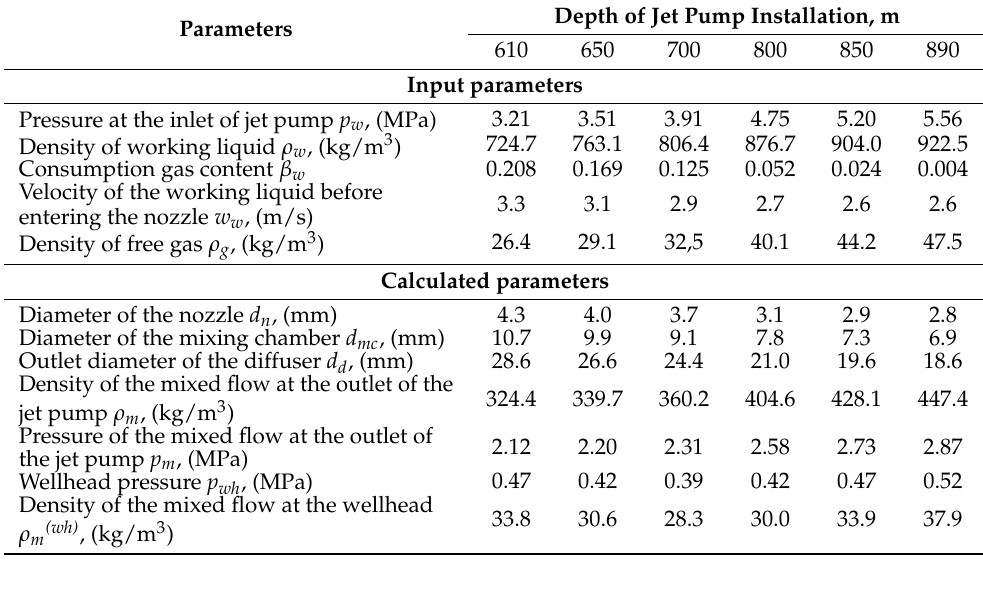
Table 1. Input and calculated parameters of the oil well and the jet pump when it is installed at different depths.